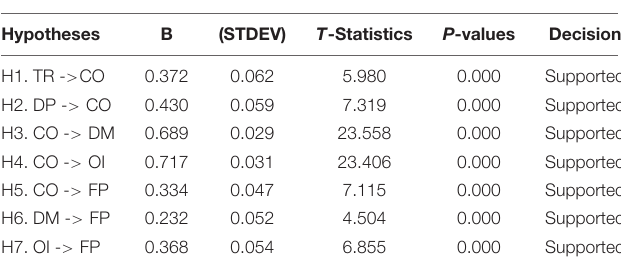
TABLE 3 | Direct effects.